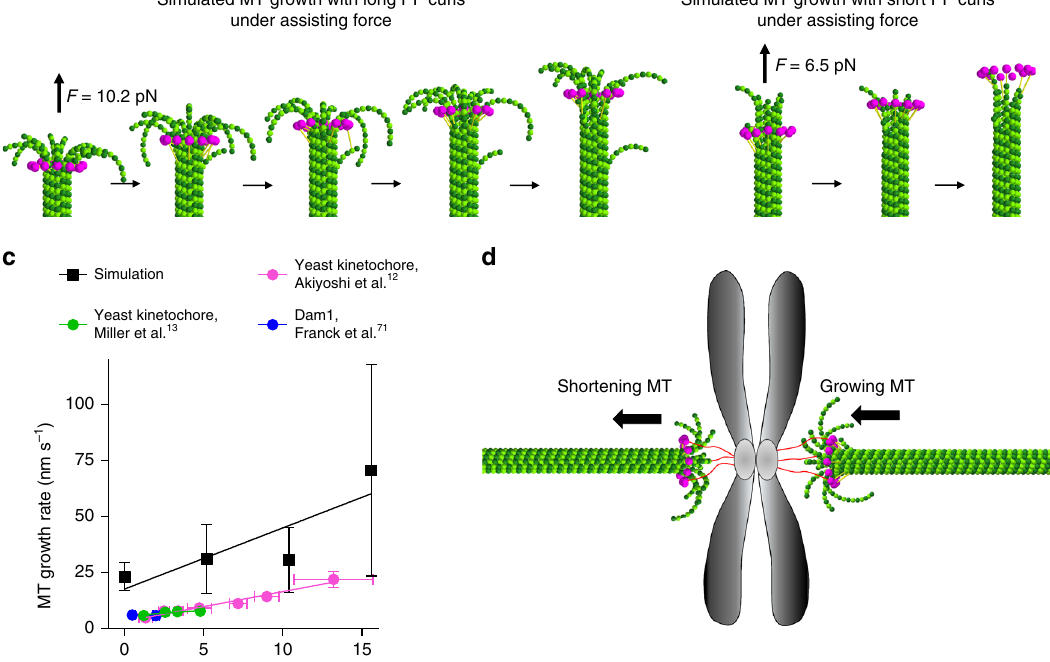
Fig. 8 MT growth with fl ared PFs can sustain assisting load and be accelerated by it. a Snapshots from a simulation of GTP-MT growth with long PF curls in the presence of a Dam1 ring. GTP hydrolysis is turned off. b Snapshots from a simulation of GTP-MT growth with ring and short PF curls. GTP hydrolysis is turned off. c Dependence of GTP-MT growth on assisting force in the model (10 µ M tubulin, 37 °C) and experimental data (15 µ M tubulin, 23 °C). The difference in MT growth rates between the simulation and experiments is likely due to the distinct temperature conditions. Simulation data points represent mean ± s.e.m. based on three repeats of each simulation; source data are provided as a Source Data fi le. d Schematic illustrating the proposed principle of synchronization of growing and shortening MTs during chromosome oscillations in